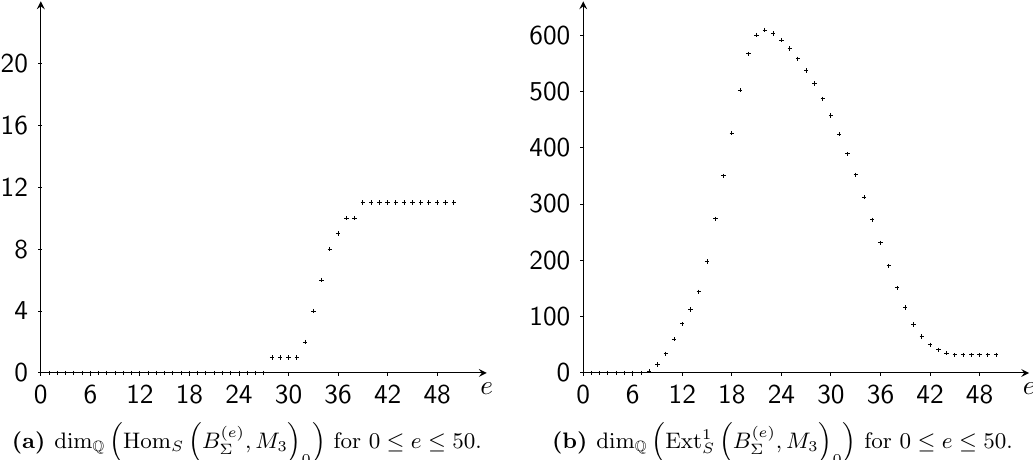
Figure 8. Computing the sheaf cohomologies of f M 3 with plesken